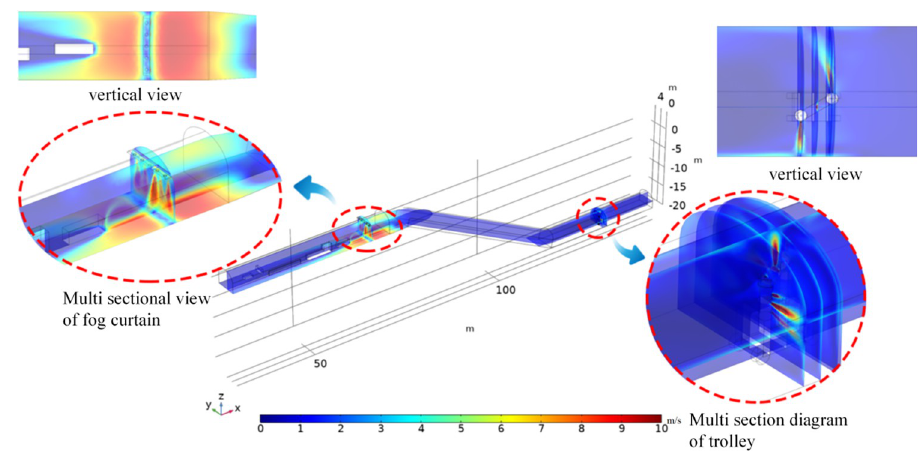
Fig 10. Installation airflow velocity distribution diagram.